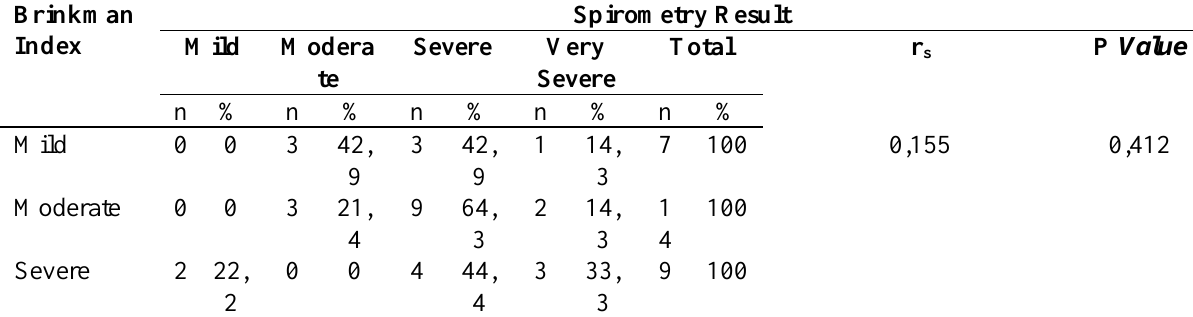
Table 5. The Relation Between Brinkman Index and Spirometry